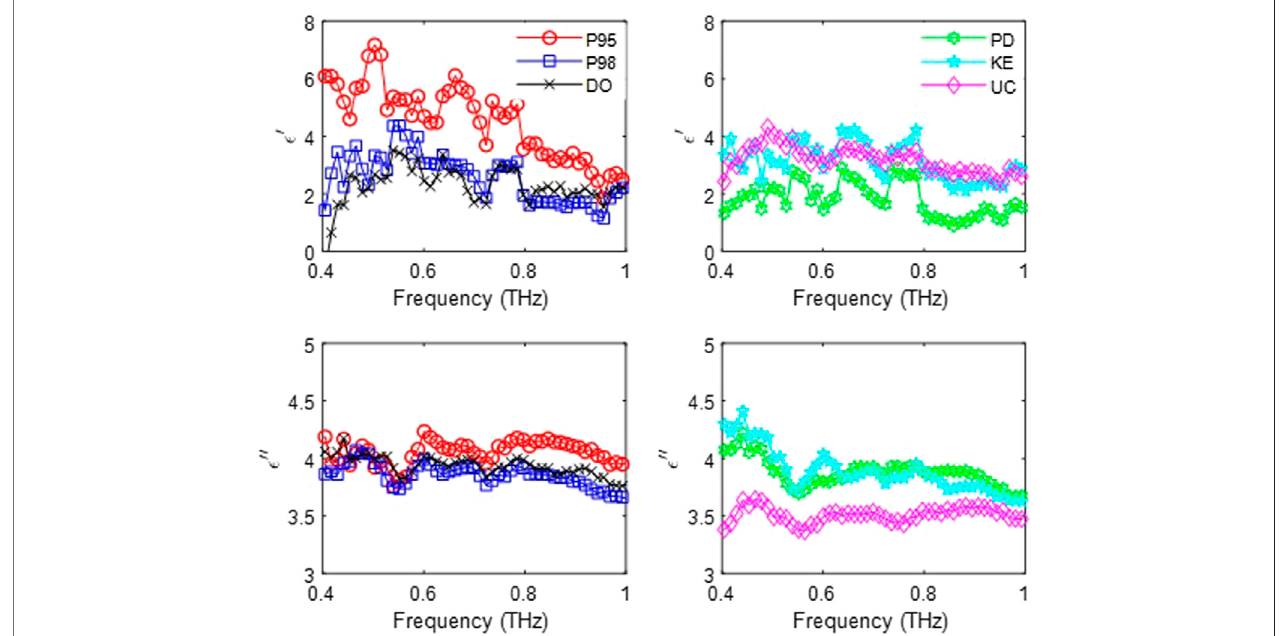
FIGURE 5 | the calculated complex permittivity of Petrol 95 (P95), Petrol 98 (P98), Diesel oil (DO), 50/50 mixed Petrol/Diesel (PD), Kerosene (KE) and Universal Bottle Cleaner (UC) (Top) real part of permittivity (Bottom) imaginary part of the permittivity.